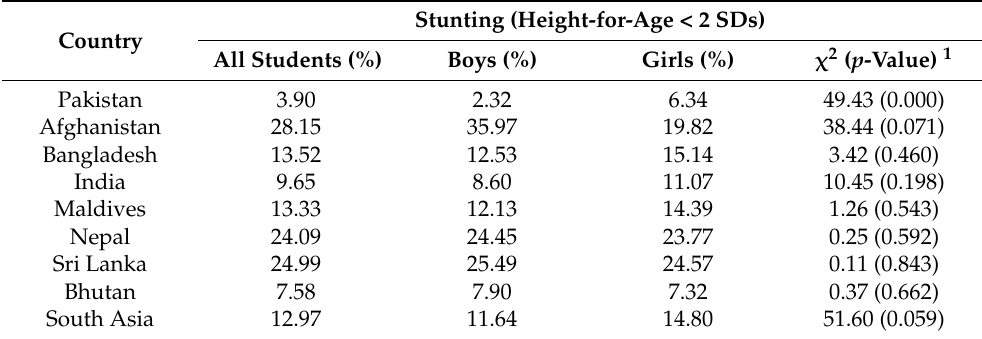
Table 2. Prevalence * of stunting among South Asian schooled adolescents aged 12–15 years old. Country